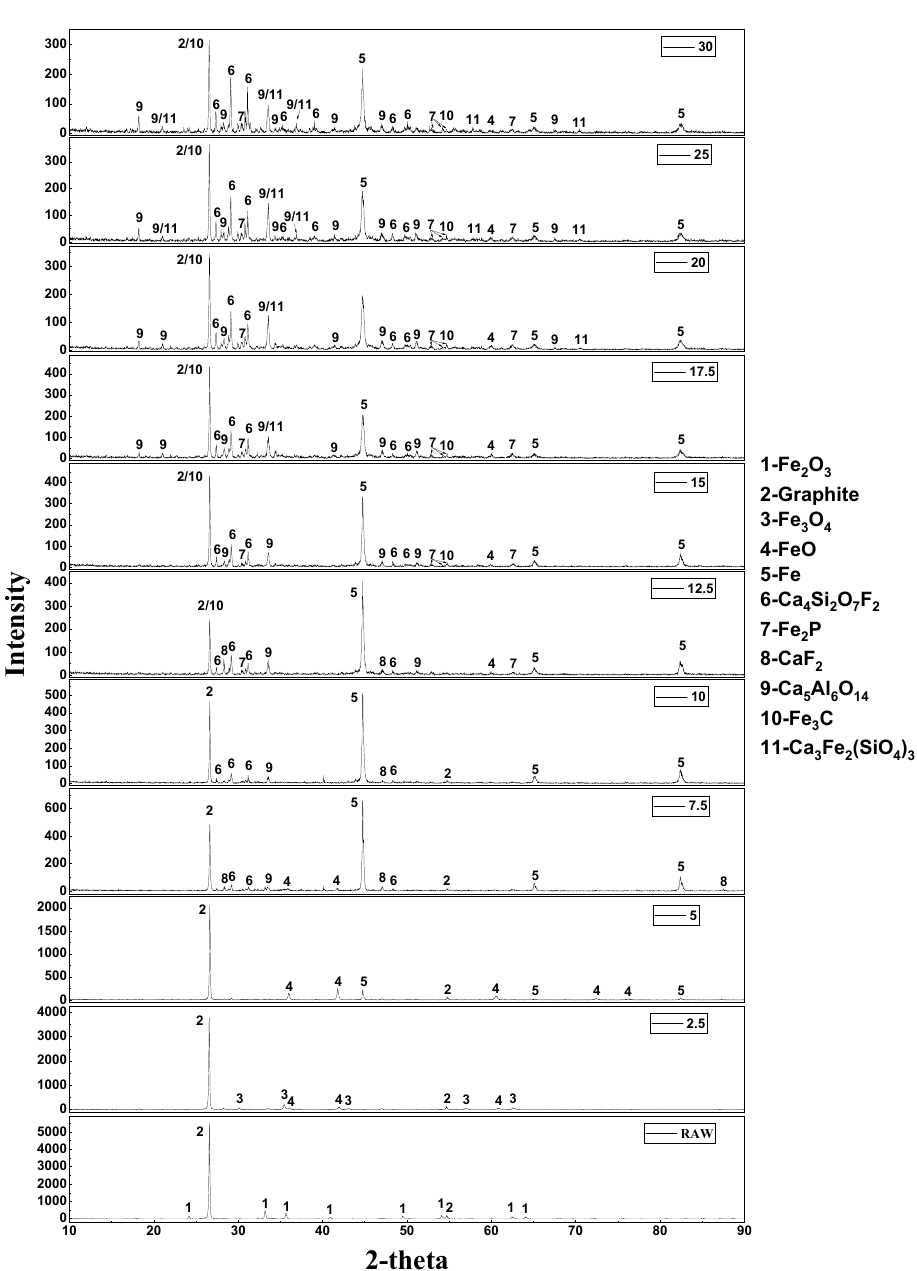
Figure 10. XRD spectra of reduced pellets at different times under nitrogen condition.